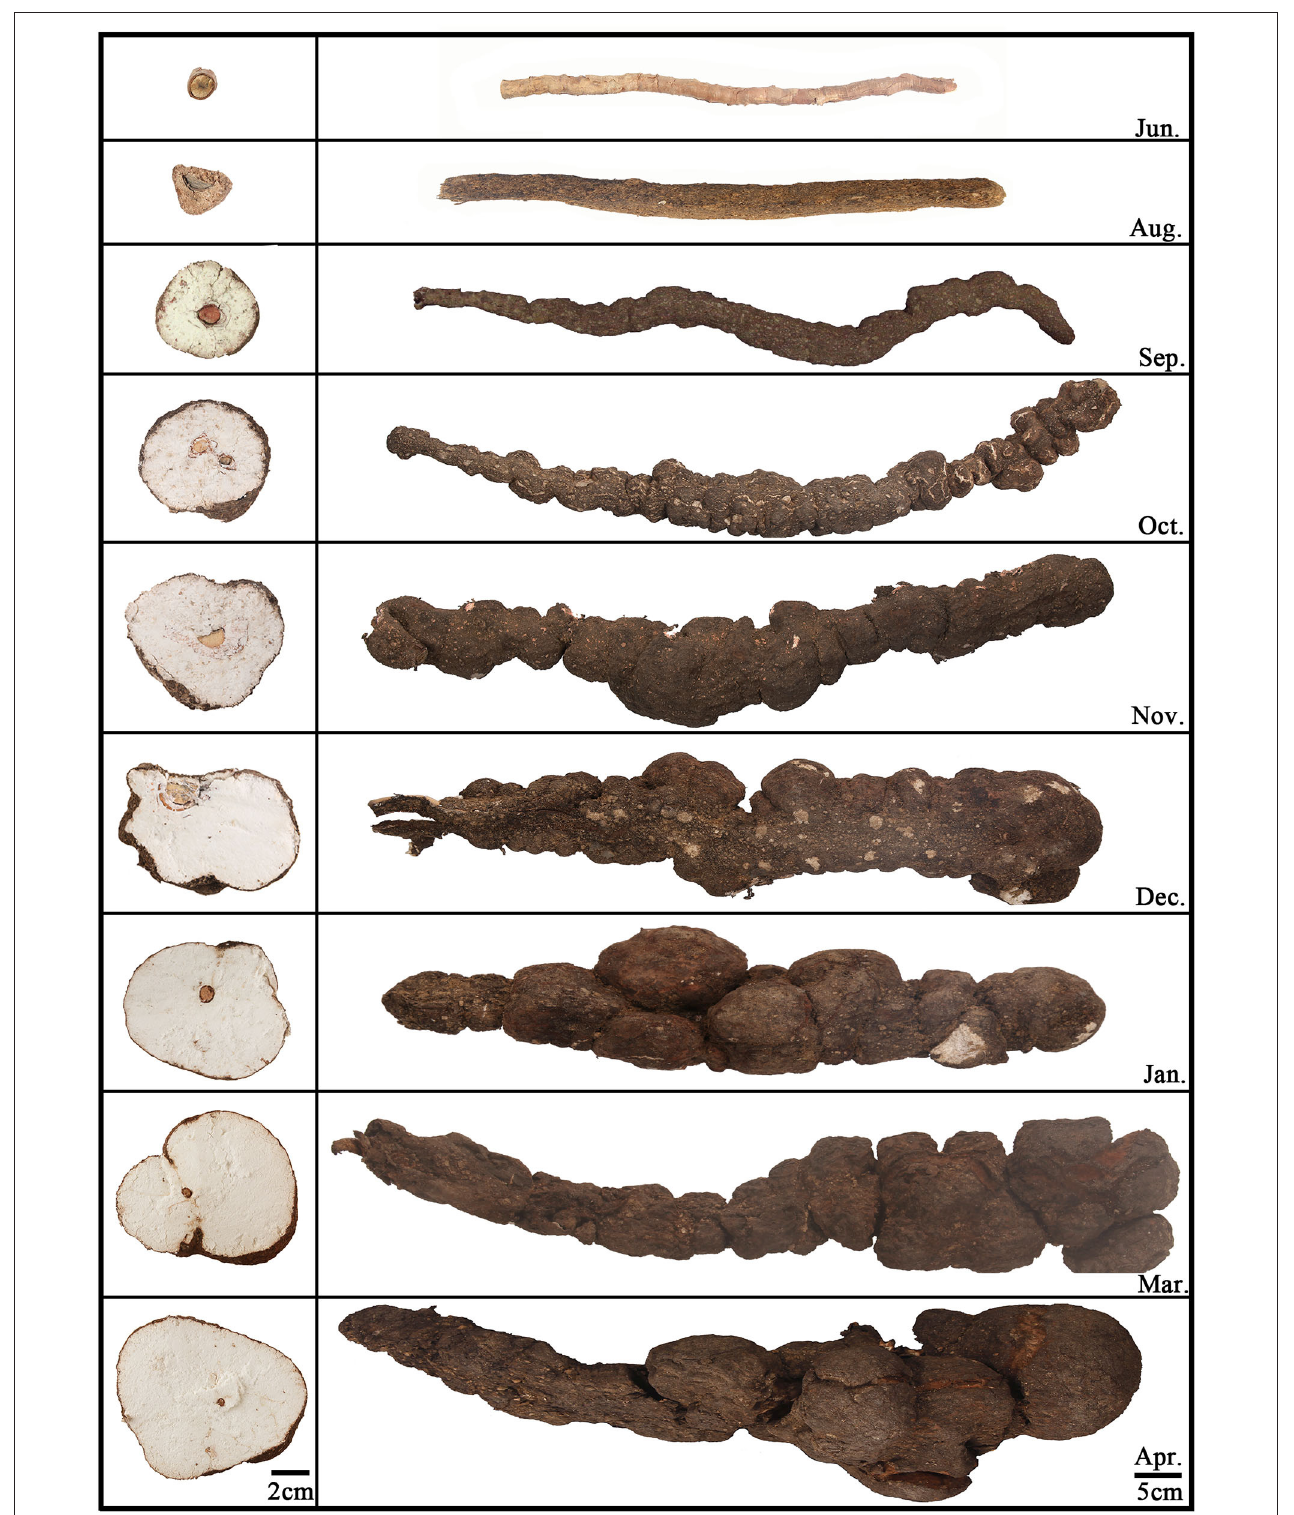
FIGURE 1 | Morphological characteristics of nine growth periods of Fushen.